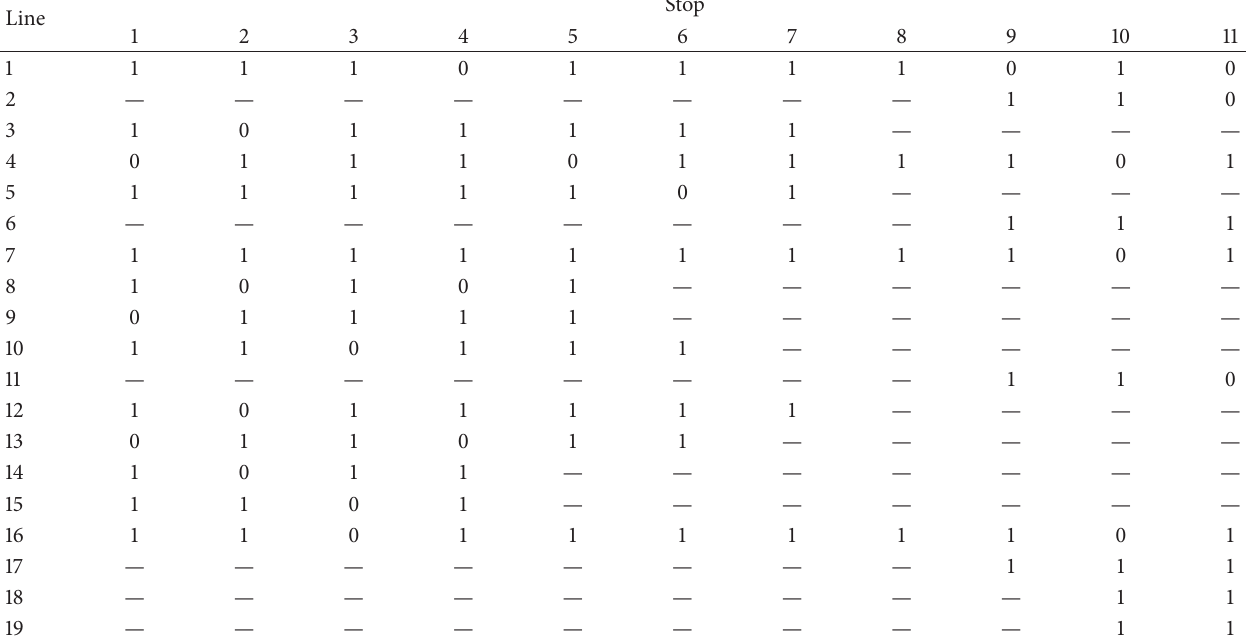
Table 5: The optimal scenario of skip-stop operation.